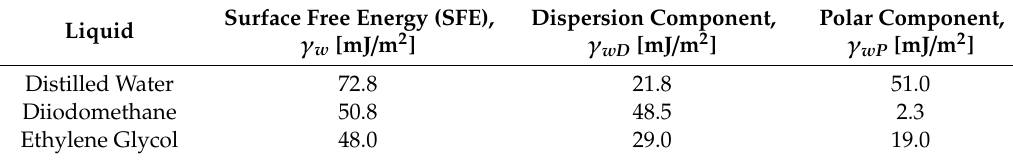
Table 2. Properties of selected measuring